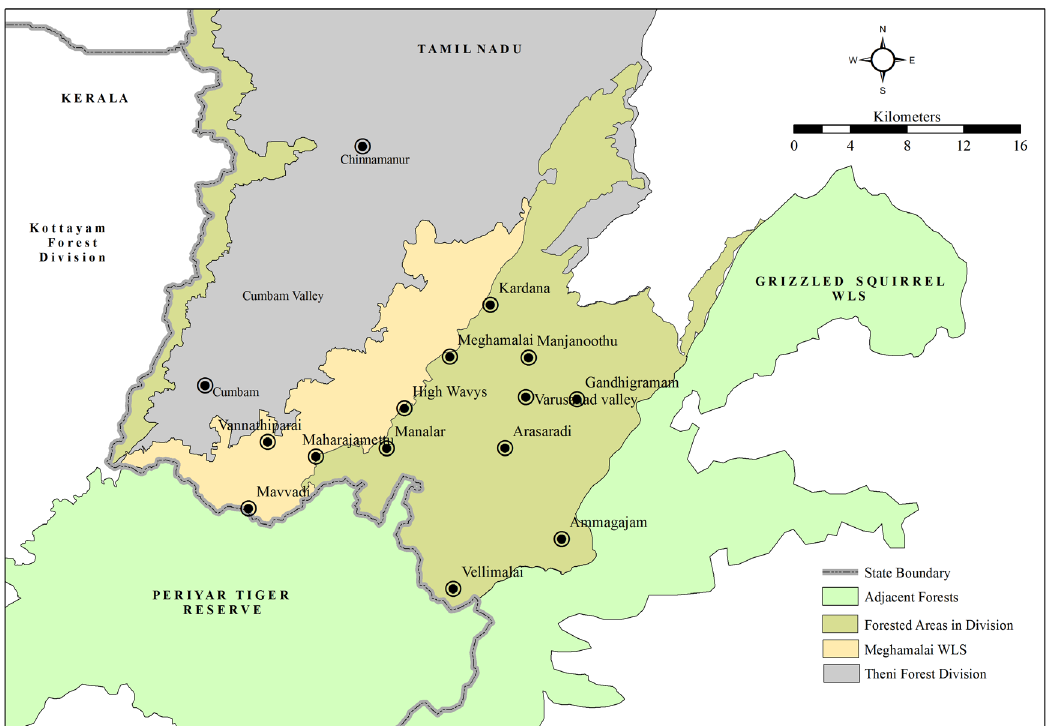
Figure 1. Surveyed areas in Meghamalai landscape, southern Western